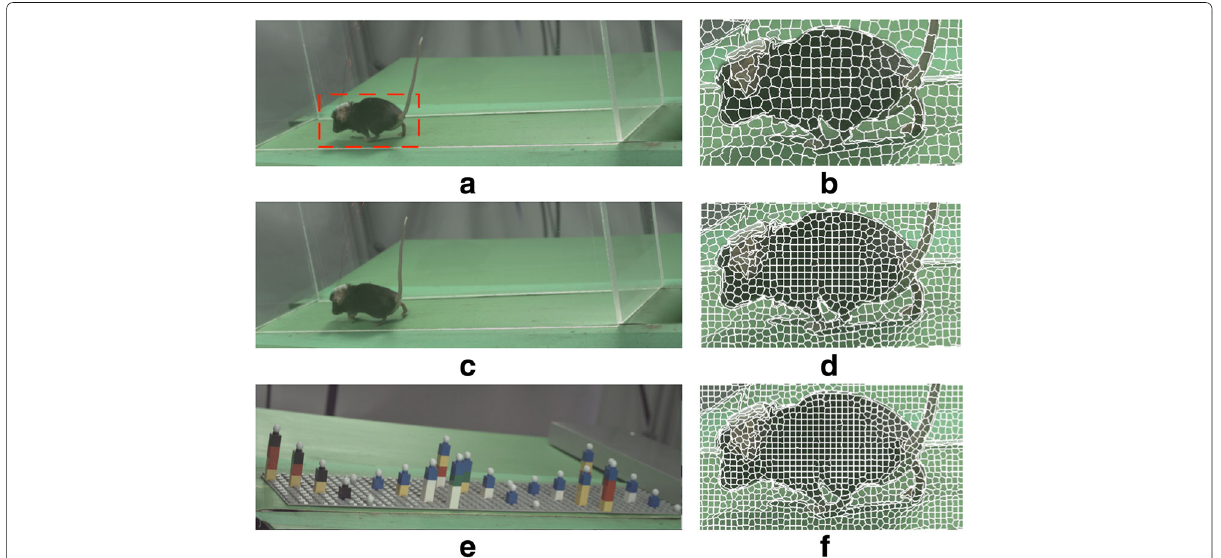
Fig. 2 a A frame captured from a C57BL/6 mouse where the paws have a “collision type II.” The SLIC results with 5000, 10,000, and 15,000 superpixels for the marked red region in a are illustrated in b , d , and f , respectively. The marked red region is selected to demonstrate a better resolution of SLIC segmentation around the mouse body; this box does not show the “sub-image” to reduce the time required for generating superpixels. Panel c shows a “collision type I” for the front paw. Note that a similar collision can occur for the hind paw. The calibration object with 25 markers is seen in e